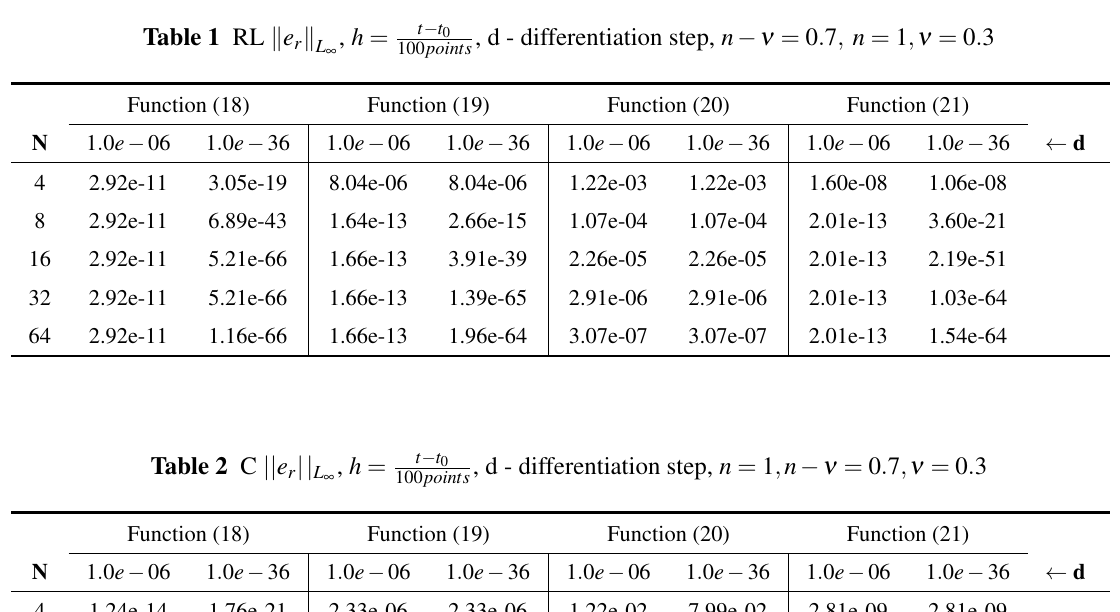
Table 1 RL (cid:107) e r (cid:107)